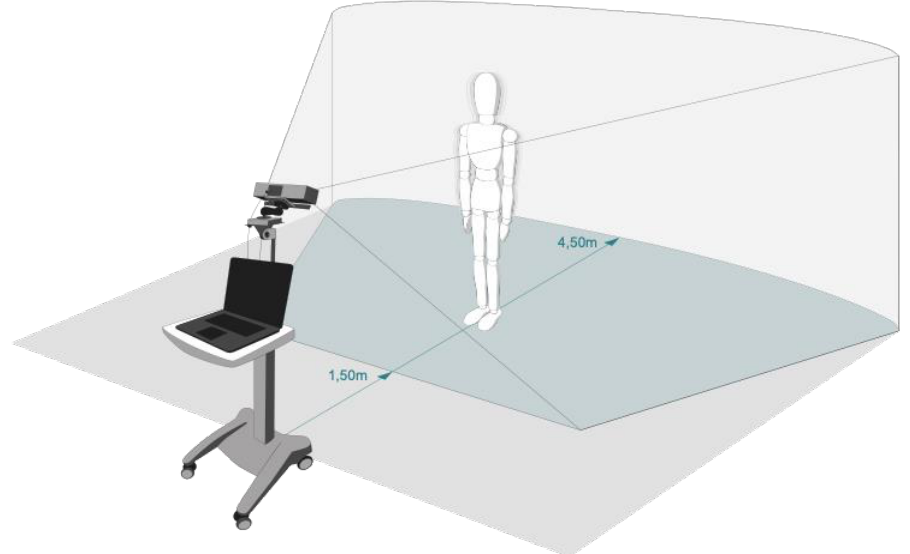
Figure 1. Technical setup of the motion capture system. Kinect camera was attached at 1.4 m height on a movable trolley with a pitch angle of roughly −9° while participants stood at a 2.5 m distance.